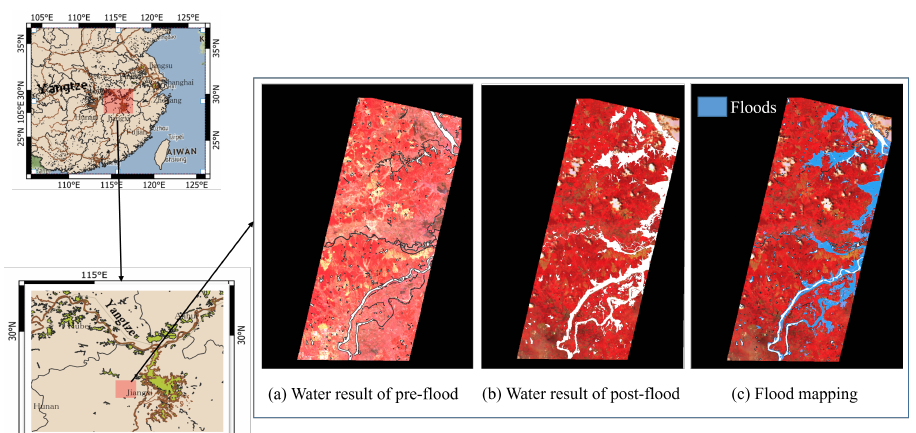
Figure 15. Flood mapping based on the pre- and post-flood Zhuhai-1 hyperspectral